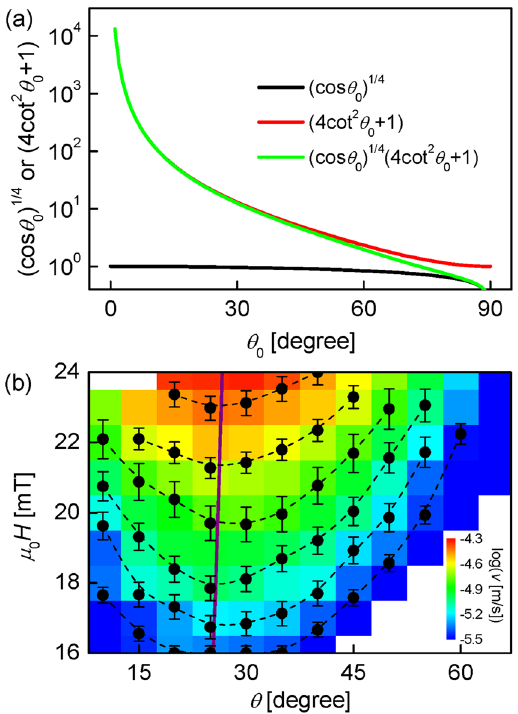
1/4 2 Figure 3. Simplification of θ θ + (cos ) (4 cot 1) and two-dimensional contour map of θ v H ( , ) as a function 0 0 1/4 , θ + (4 cot 1) 2 of θ and H . ( a ) Numerical calculations of θ (cos ) 0 0 θ θ v H ( , ) plotted with respect to θ and H . The colour contrast represents 0 . ( b ) Two-dimensional contour map of the value of v log( ) with scale bar on the right lower end. The purple solid line is the numerical evaluation of Eq. (3). The black dashed lines guide the eyes to the equi-speed